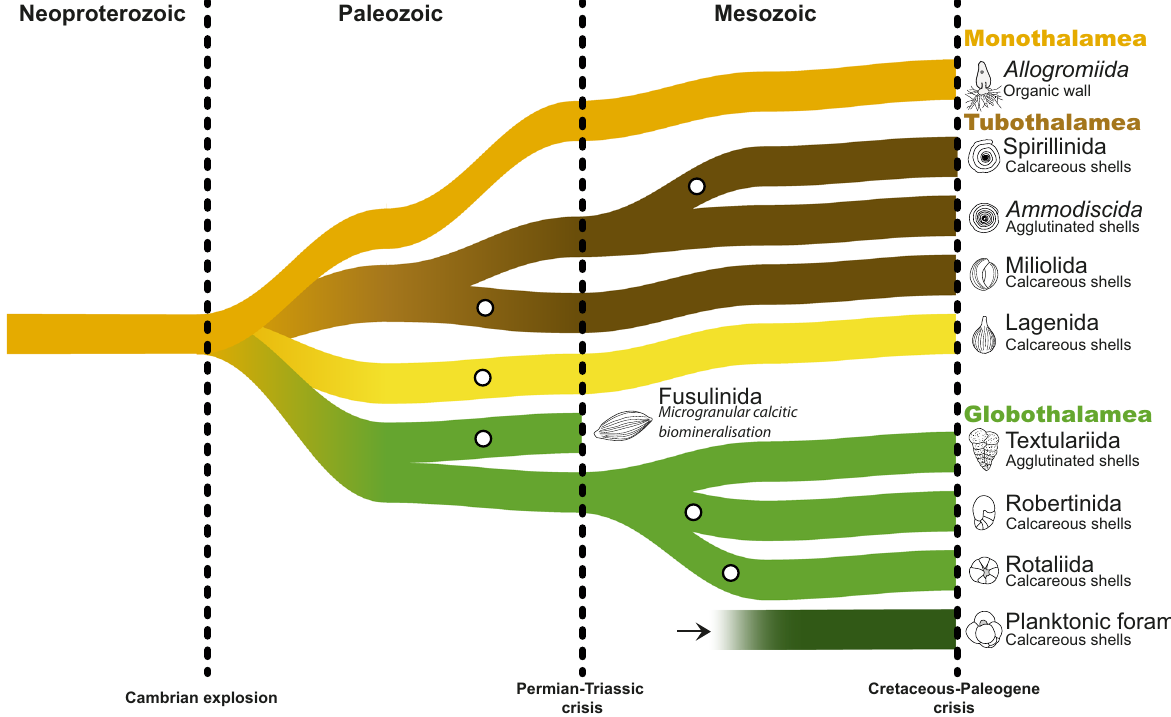
Fig. 1 | Simpli fi ed evolutionary history of foraminifera. The scheme depicts the diversi fi cation of foraminifera from their emergence in the Precambrian until the end of the Mesozoic with a simpli fi ed stratigraphy. The polytomies re fl ect uncer- tainties in the evolutionary relationships between the depicted lineages. The Glo- bothalamea and Tubothalamea have a class rank and the status of the